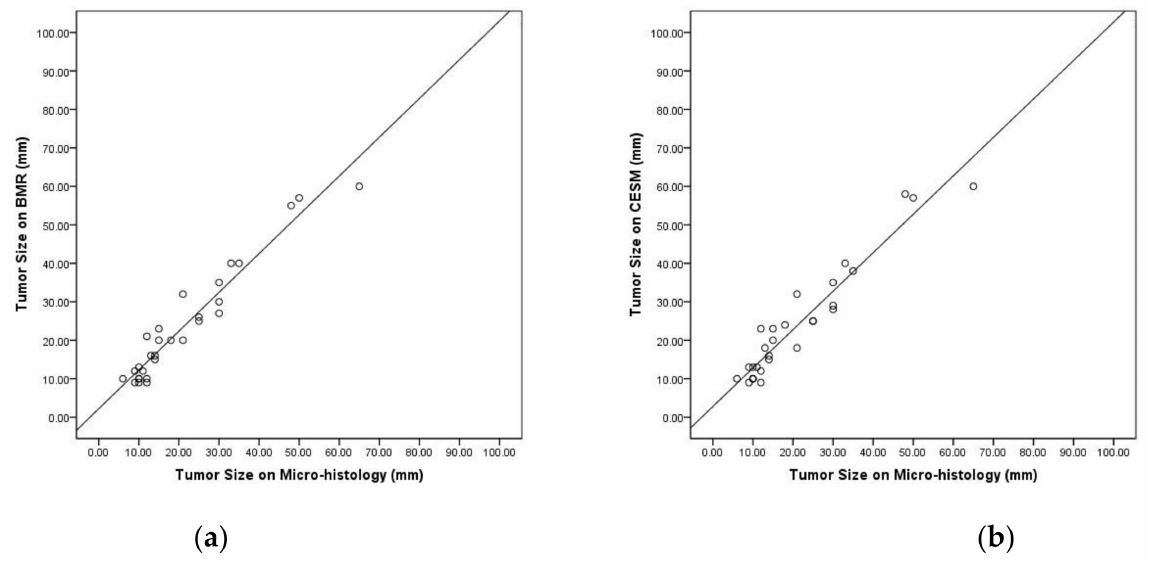
Figure 3. Pearson correlations of index cancers sizes of ( a ) breast magnetic resonance (r = 0.945, p < 0.001) and ( b ) contrast-enhanced spectral mammography (r = 0.937, p < 0.001) versus micro-